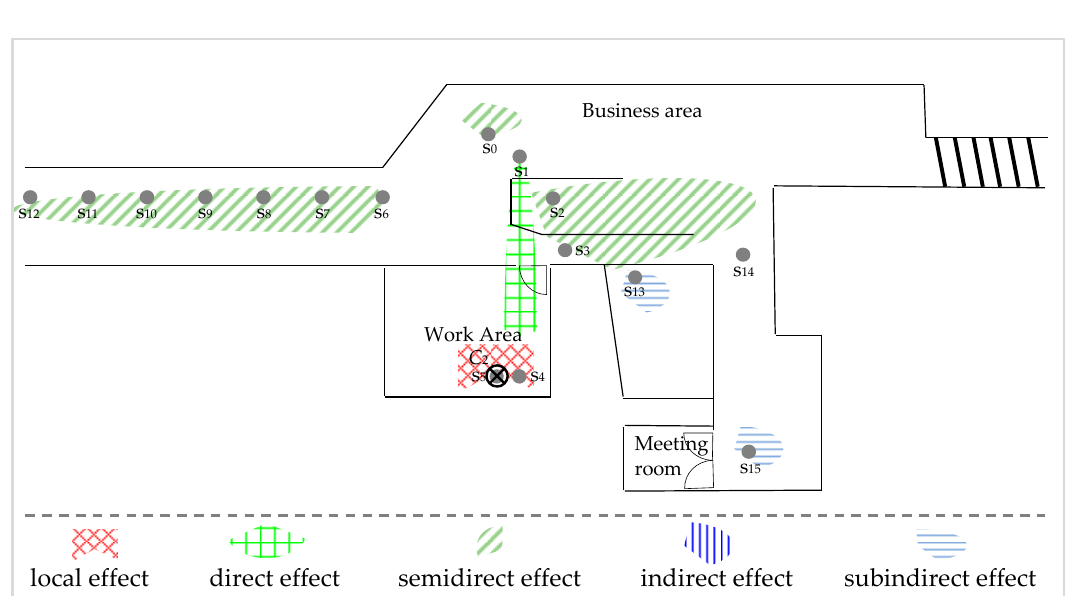
Figure 12. Various e ff ects for C 2 and 16 embedded system layouts.